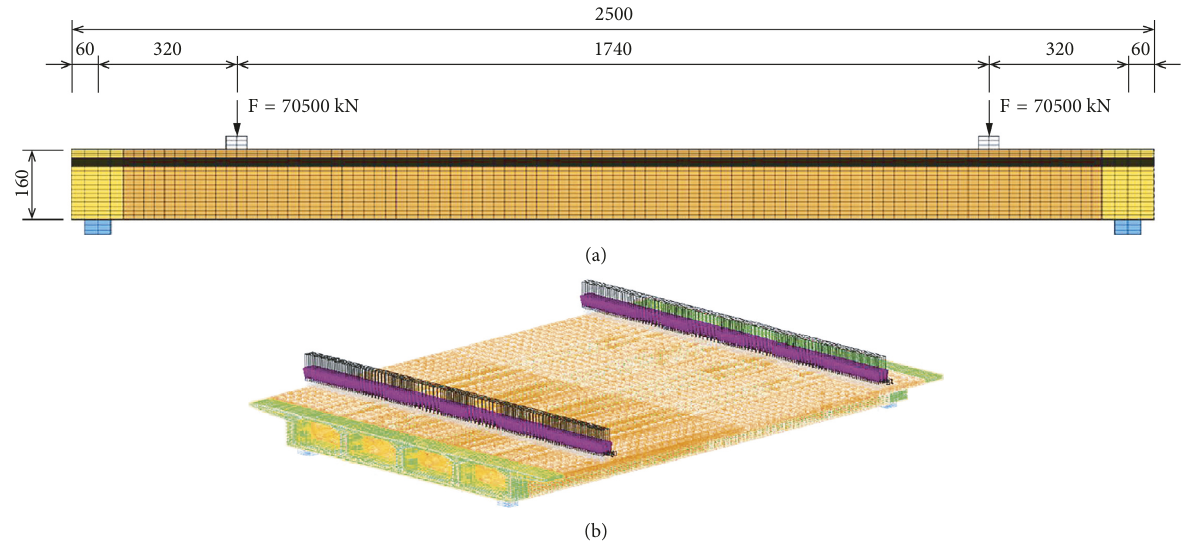
Figure 13: Model of the box girder (unit: cm). (a) Elevation of the model. (b) Finite element of steel bar.